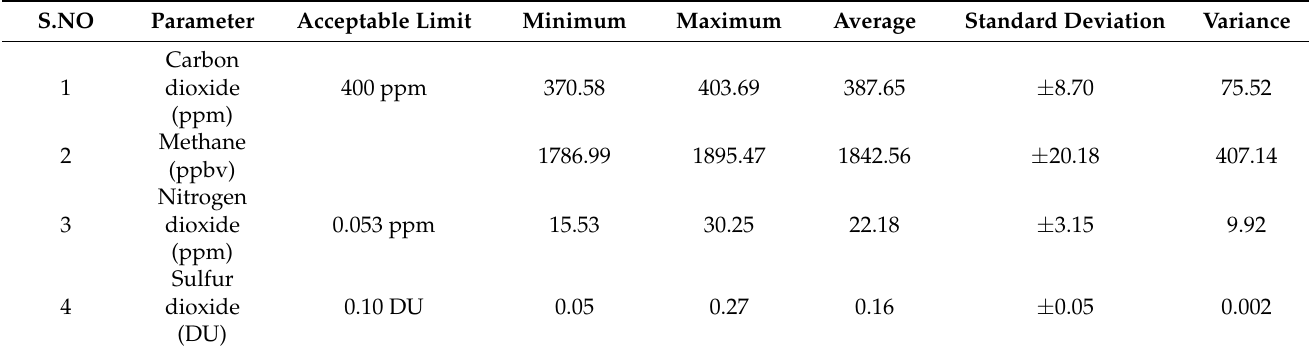
Table 5. Long-term statistical summary of pollutant concentrations in the study